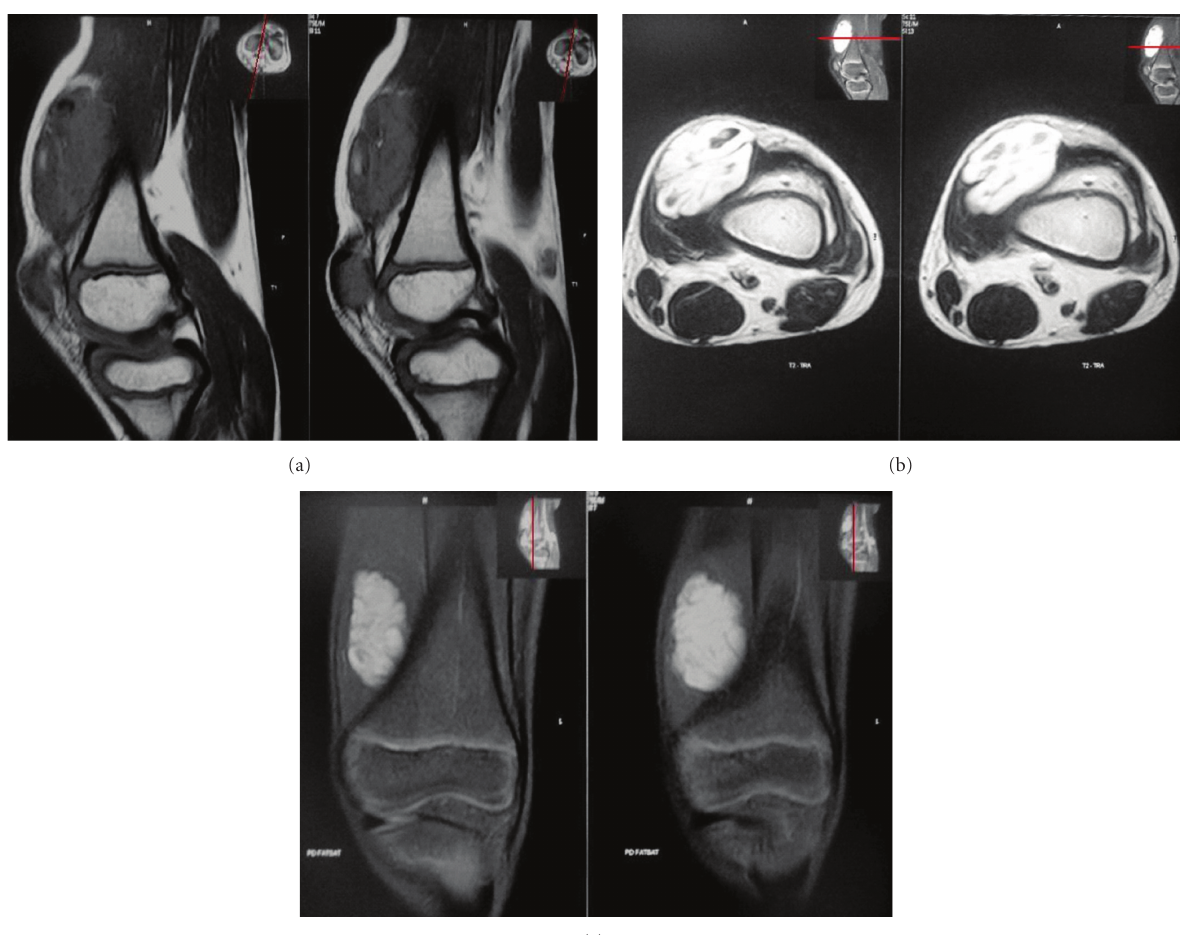
Figure 3: MRI reveals soft tissue mass in the vastus medialis which with high signal intensity on T 1 , T 2 , and PD FAT SAT images, with hypointense calcifications